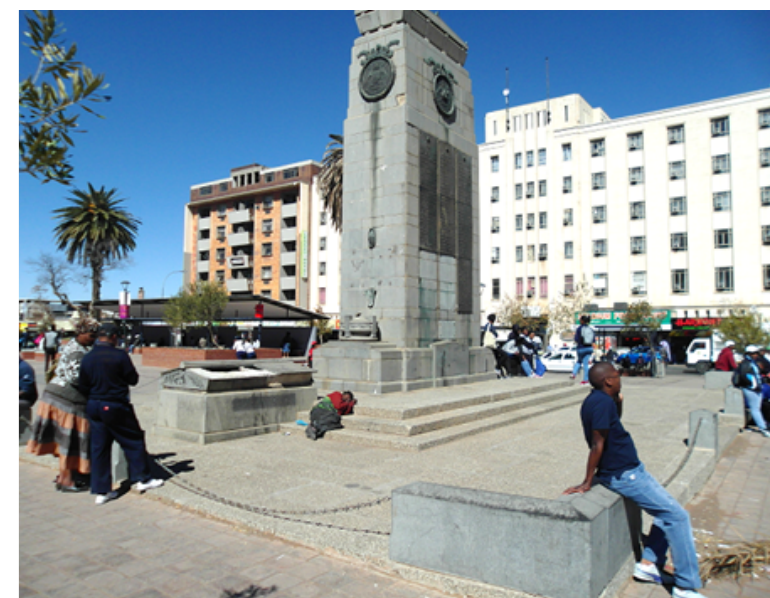
Figure 3. Appropriating Hoffman Square. Source: photograph by author. net. It creates an incessant spectacle between itself and users who take pictures in front of it night and day. The secretion of a clandestine tourist effect by the war mon- ument that is managed by Free State Heritage, evokes heterotopia. According to Foucault (1984/1967, pp. 3–4), heterotopia is “something like counter-sites…effectively enacted utopia in which the real sites…found within the culture, are simultaneously represented, contested, and inverted”. Lefebvre (1991) considers heterotopias to be mutually repellent spaces whose utopias (urban ideals) are occupied by the symbolic (lived) and the imaginary (conceived). Therefore, Hoffman Square’s mutually re- pellent political heritage sites—along with the Africans that were once excluded in Bloemfontein—represent